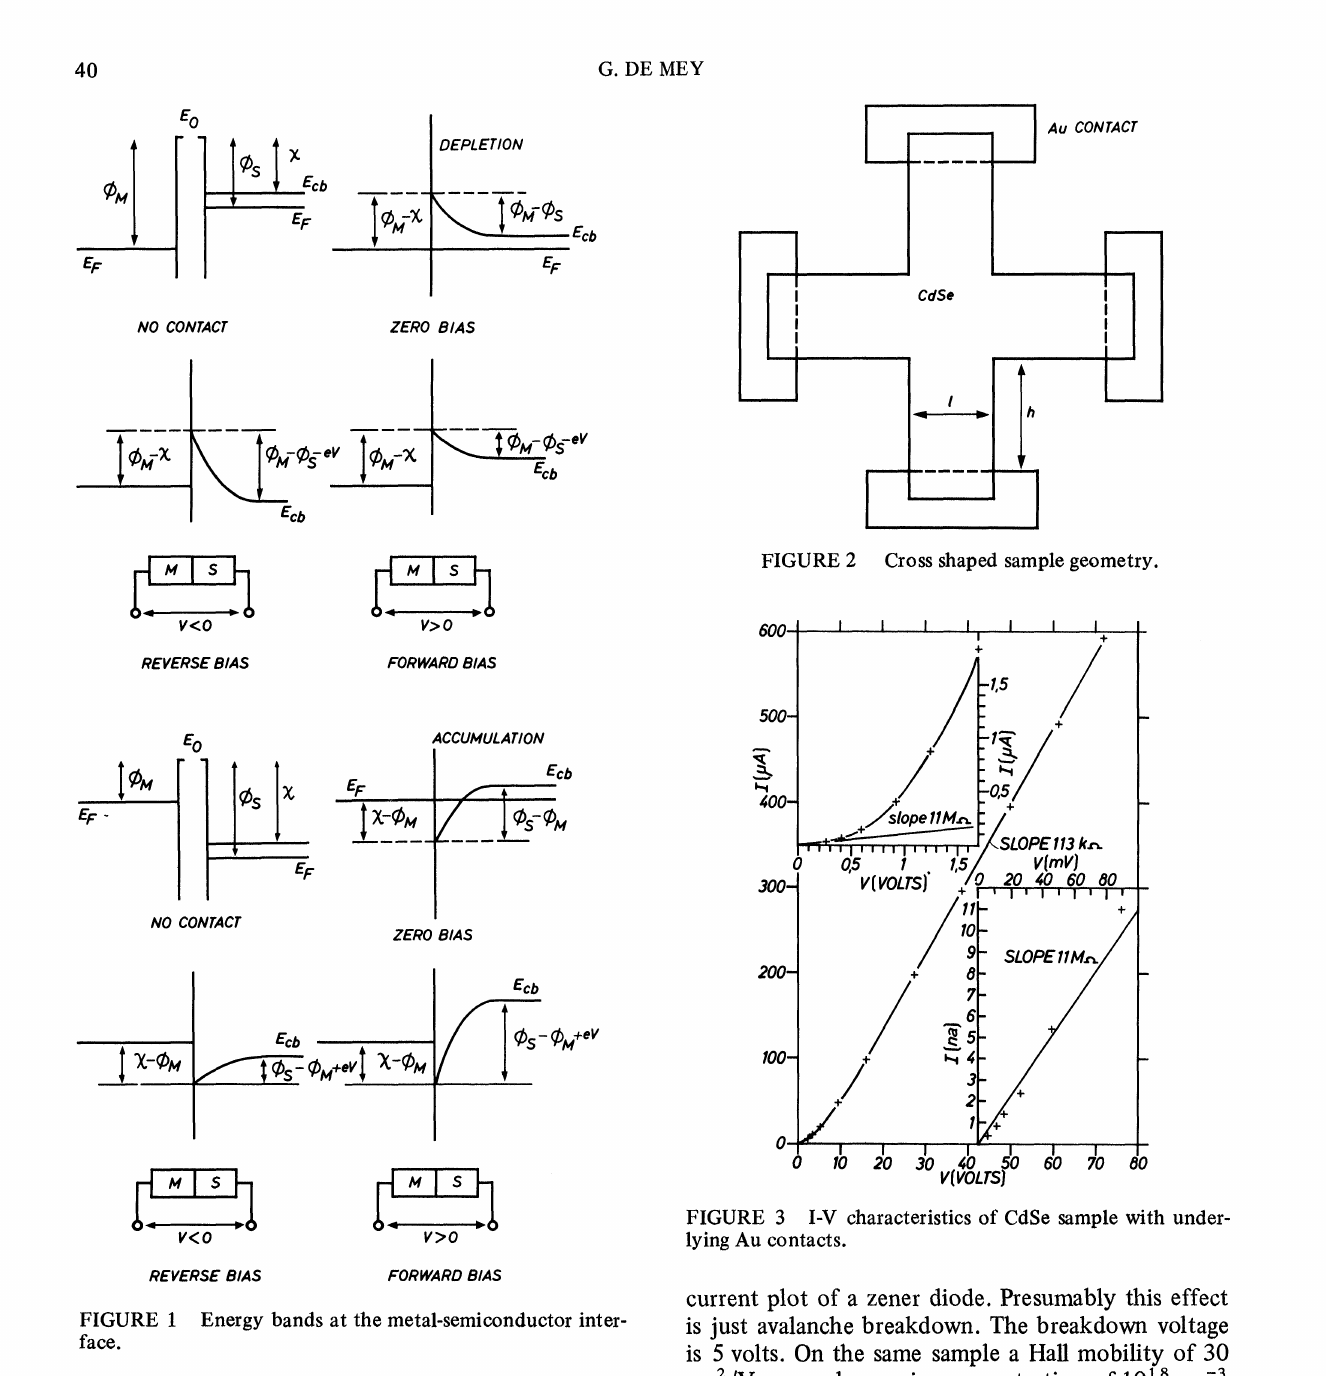
FIGURE Energy bands at the metal-semiconductor inter- face.